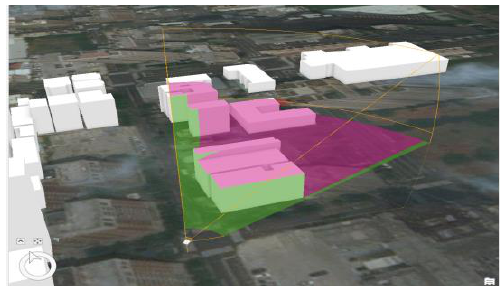
Figure 9 The 3D coverage of a single CCTV